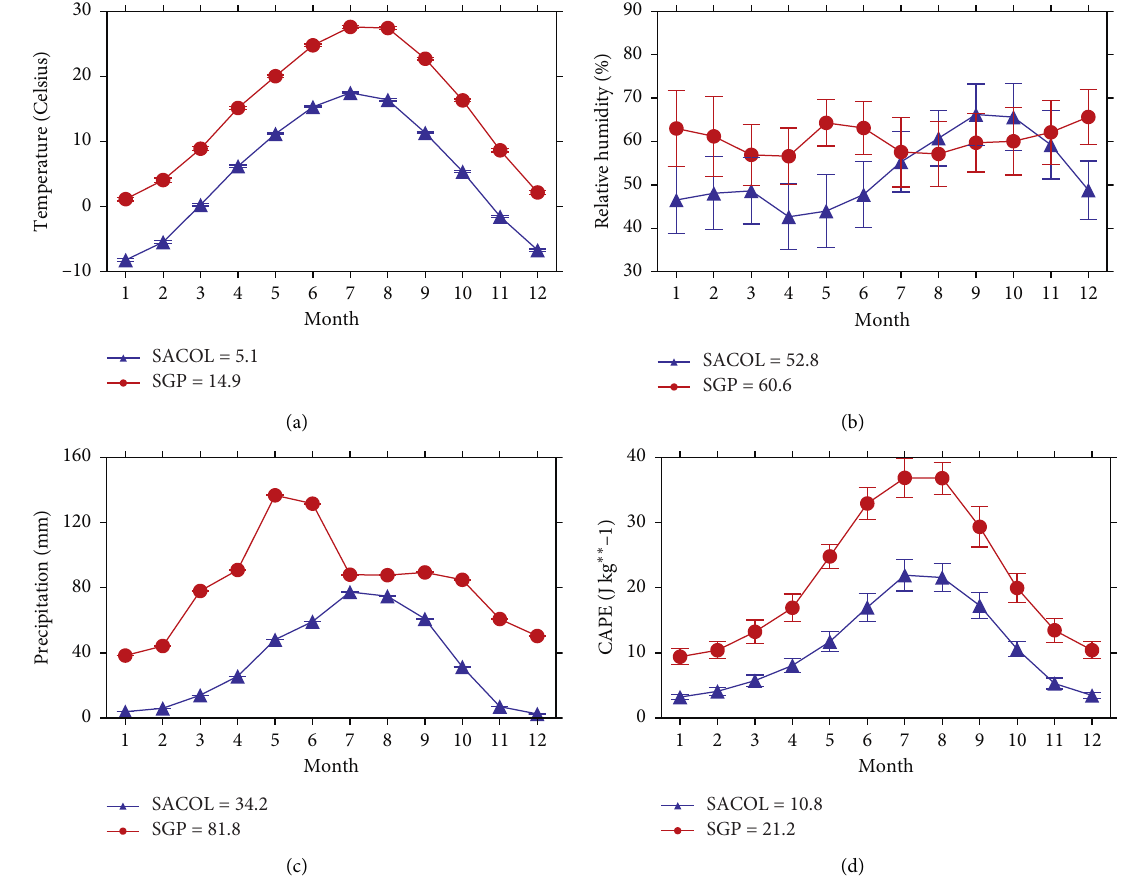
Figure 1: Monthly (a) air temperature, (b) relative humidity from the NCEP reanalysis (1948–2015), (c) precipitation amount from the GPCP (1979–2015), and (d) convective available potential energy (CAPE) from the ECMWF (1979–2015) at the SGP (in red) and SACOL (in blue) sites. Annual mean values are given in the upper left corners of the panels and error bars show the standard deviations. 0102030